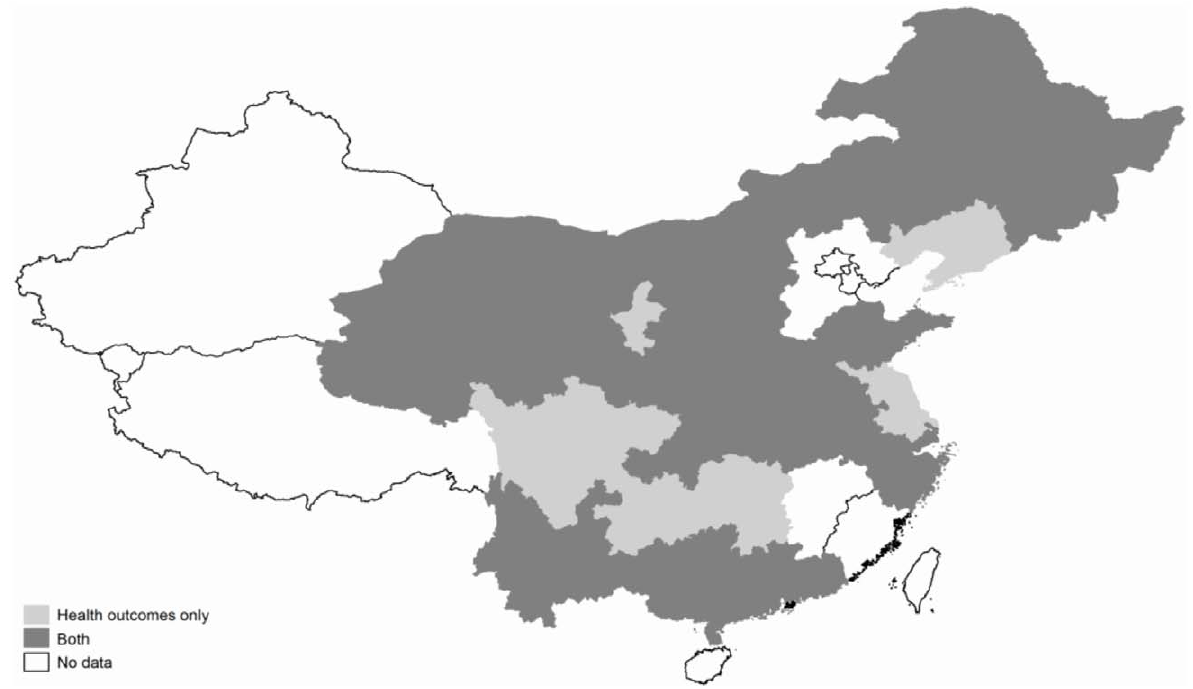
Figure 2. Study site of the 15 studies.